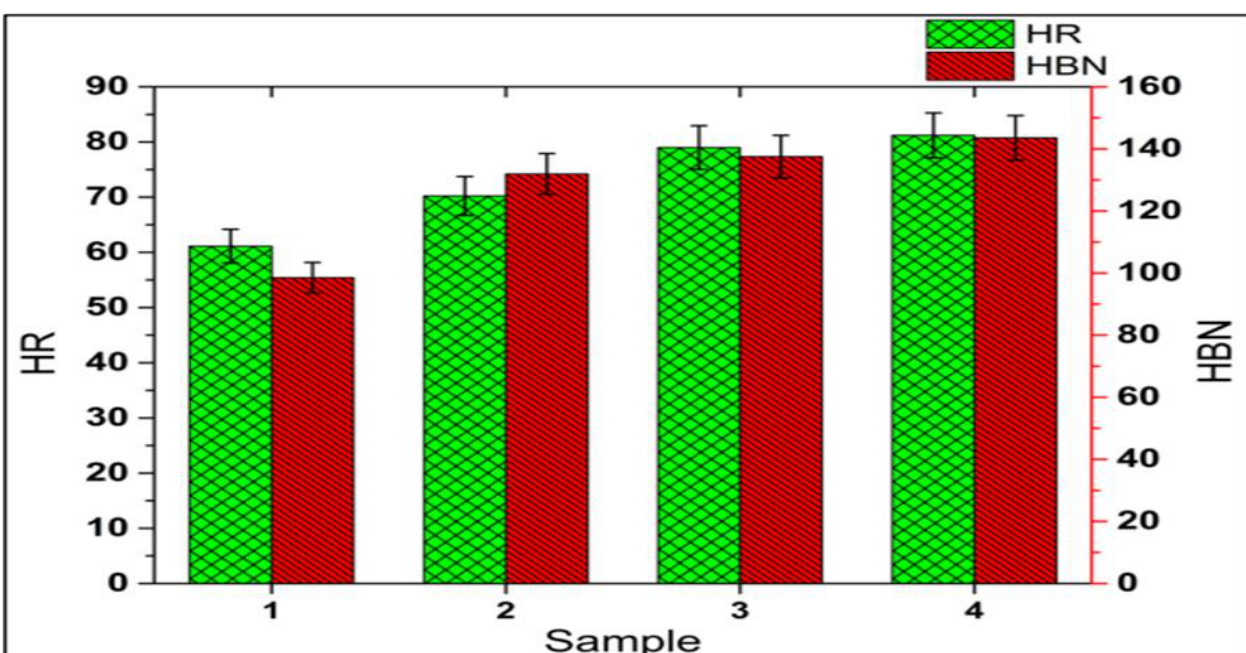
Figure 11. AA7075 (base alloy, sample 1), AA7075–5wt%SiC (MMC, sample 2), AA7075–5wt%SiC– 3wt%RHA (s-HMMC, sample 3), and AA7075–5wt%SiC–3wt%RHA–1wt%CES all had average valves of ultimate tensile strength and percentage elongation (n-HMMC, sample 4).